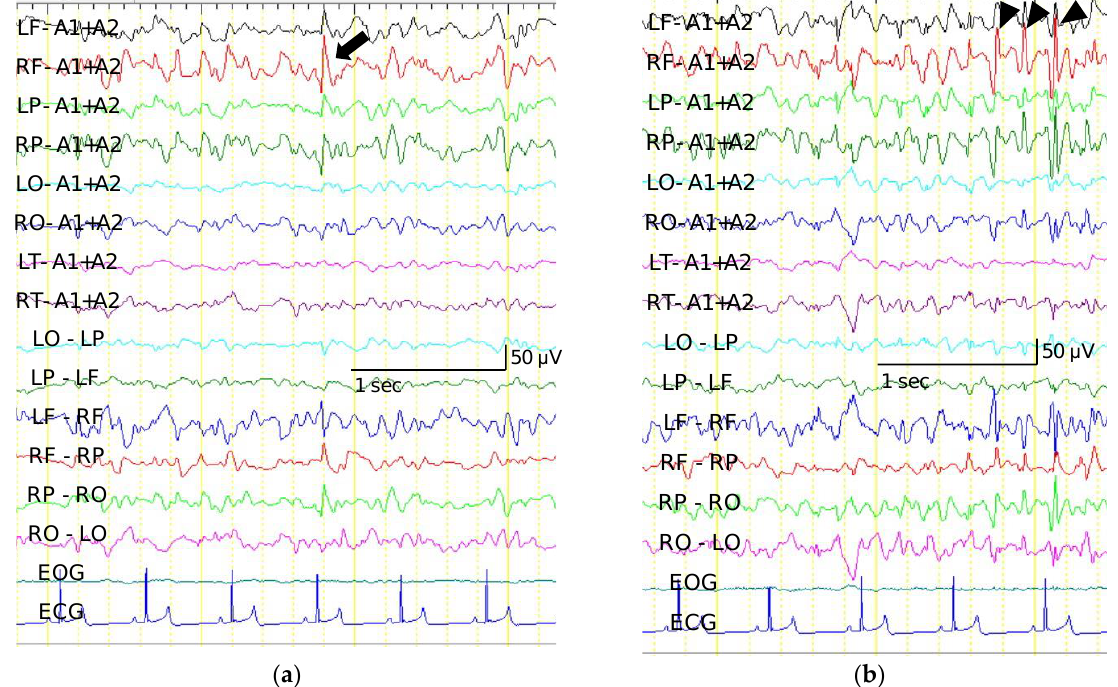
Figure 3. Screenshots of an electroencephalogram recording before ( a ) and after ( b ) the administration of bemegride in dog 1. The irritative zone was identified as the same region (i.e., right frontal) in the baseline and activation periods. An isolated sharp wave with a right frontal dominance (black arrow) was rarely observed (0.2/minute) before the administration of bemegride ( a ). A series of spikes (black arrowheads) newly appeared. Isolated spikes and a series of spikes with a right frontal dominance were more frequently noted (1.6/minute) after the administration of bemegride ( b ). Sensitivity: 10 µV, time constant: 0.3 s, high-frequency filter: 60 Hz, and notch filter: off.